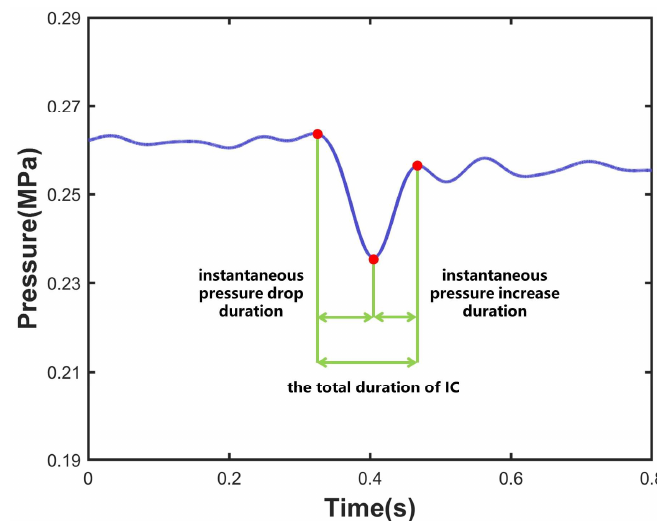
Figure 3. Definition of the total duration of IC.